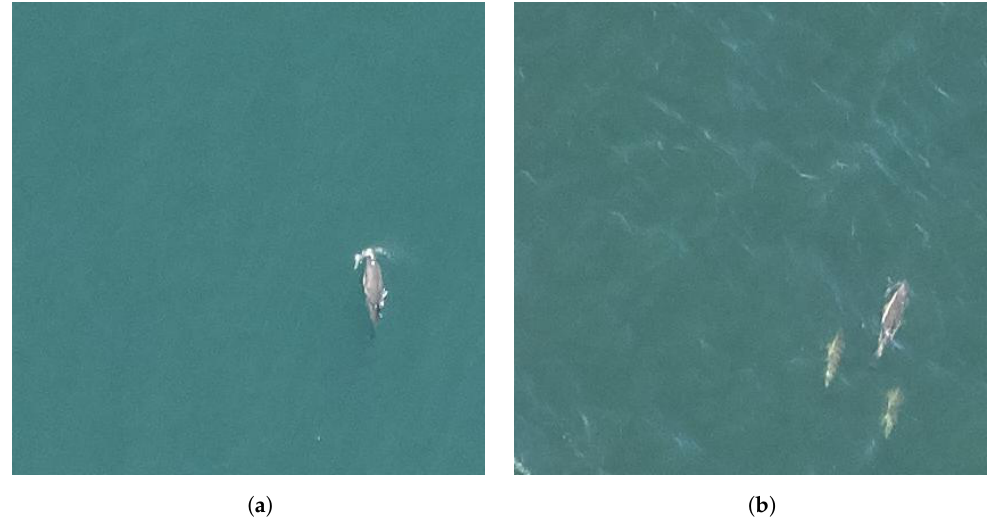
Figure 1. Dolphins of the Delphinus delphis ( a ) and Stenella coeruleoalba ( b ) species. 2. The appearance of marine animals changes as they swim deeper in the ocean, leading to ground-truth annotations with different confidence levels. For instance, in the images of Figure 2, the presence of dolphins of the Delphinus delphis species was con- firmed by specialists, but lower confidence levels were assigned to those annotations due to their blurry appearance.